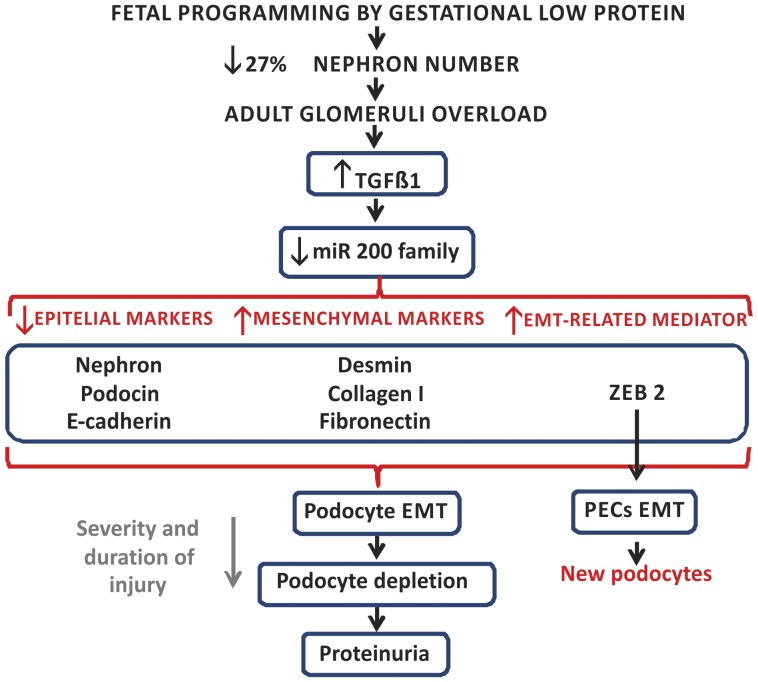
Schematic representation of proposed fetal programming consequences in cells of the renal corpuscles from adult rats.Gestational low protein diet leads to a reduction of 27% in nephron number and adult hypertension. We suppose that glomeruli overload is an initial insult that starts a cascade of events including an early inflammatory phase followed by a fibrogenic response. The downregulation of the microRNA-200 family, in response to enhanced TGFβ 1 expression, results in the reduction of epithelial markers and enhancement in mesenchymal markers and in ZEB 2, an EMT mediator. Podocytes will undergo EMT to escape apoptosis, which results in podocyte simplification, which leads to an impaired glomerular filtration barrier ensuring the onset of proteinuria. Depending of the severity and duration of injury, there may be a podocyte loss exacerbating proteinuria. PECs will also undergo EMT for differentiation into new podocytes in an attempt to attenuate the glomerular function loss (modified from Liu, 2010) [5].